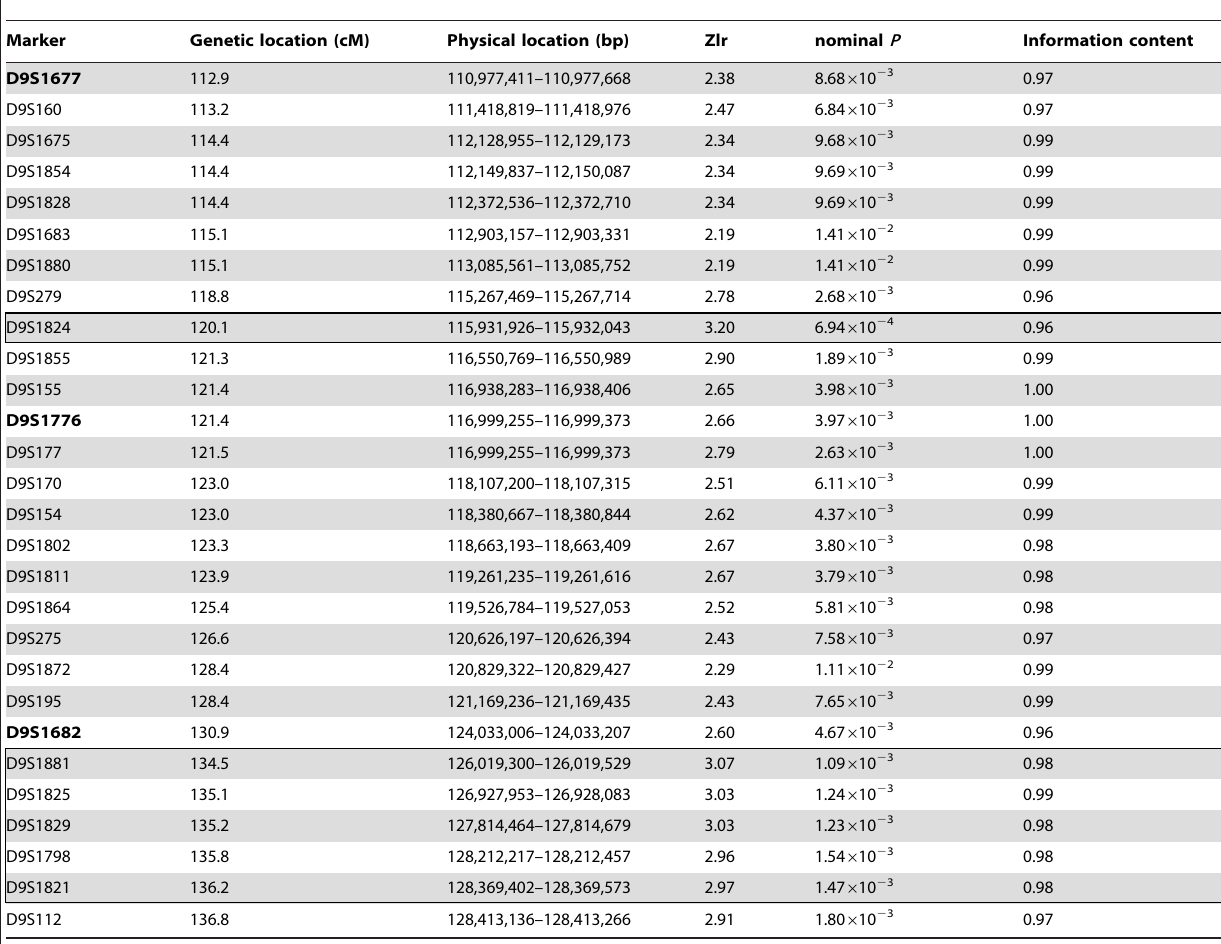
Table 2. Results of linkage analysis of 28 microsatellite markers spanning the SPA2 locus.